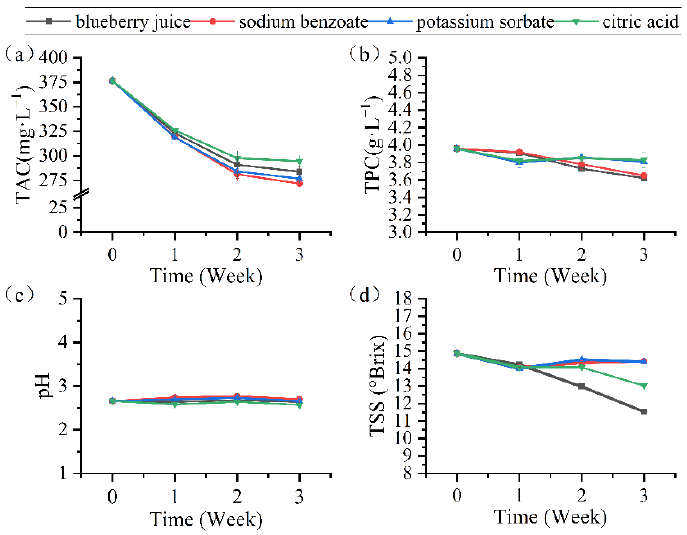
Figure 6. Changes of TAC ( a ), TPC ( b ), pH ( c ), and TSS ( d ) in concentrated blueberry juice with different DSs during storage.